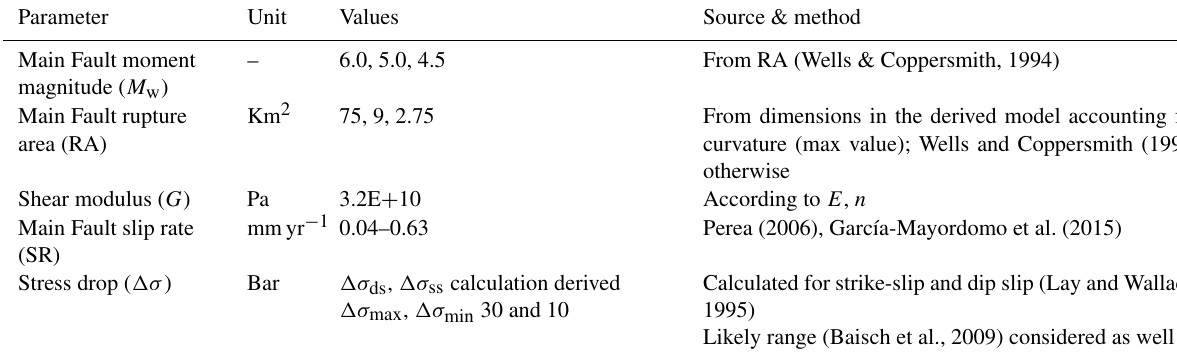
Table C4. Needed parameters for computing the shortening of the seismic cycle as described in Sect. 3.2. Parameter Main Fault moment Main Fault rupture From dimensions in the derived model accounting for Main Fault slip rate